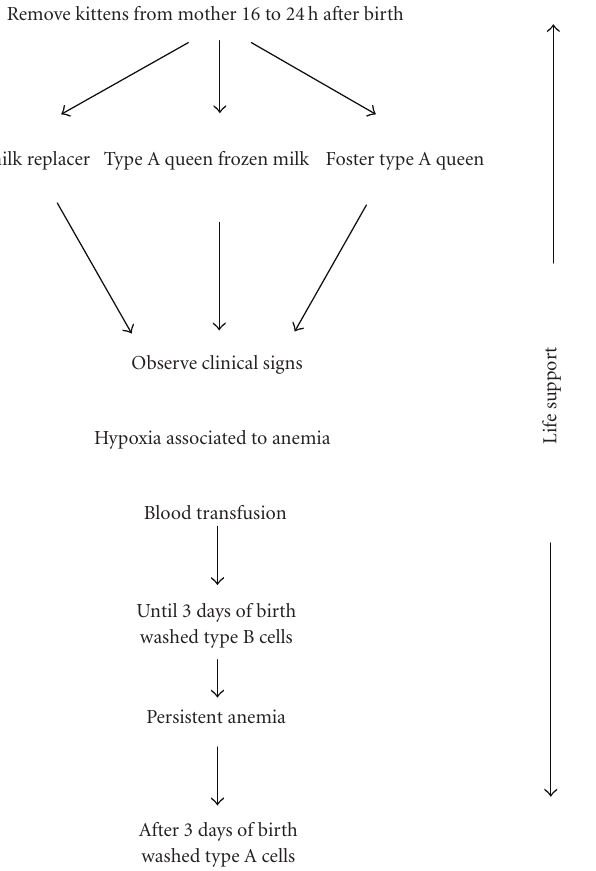
Figure 2: Schematic representation of feline neonatal isoerythrolysis treatment. To wash red blood cells, 2 to 3 mL donor blood should be collected into EDTA and centrifuged; the supernatant should then be discarded. The blood is restored with isotonic saline solution into twice its volume and again centrifuged. After discarding supernatant, repeat this action and dilute cells to transfusion with an equal saline volume.